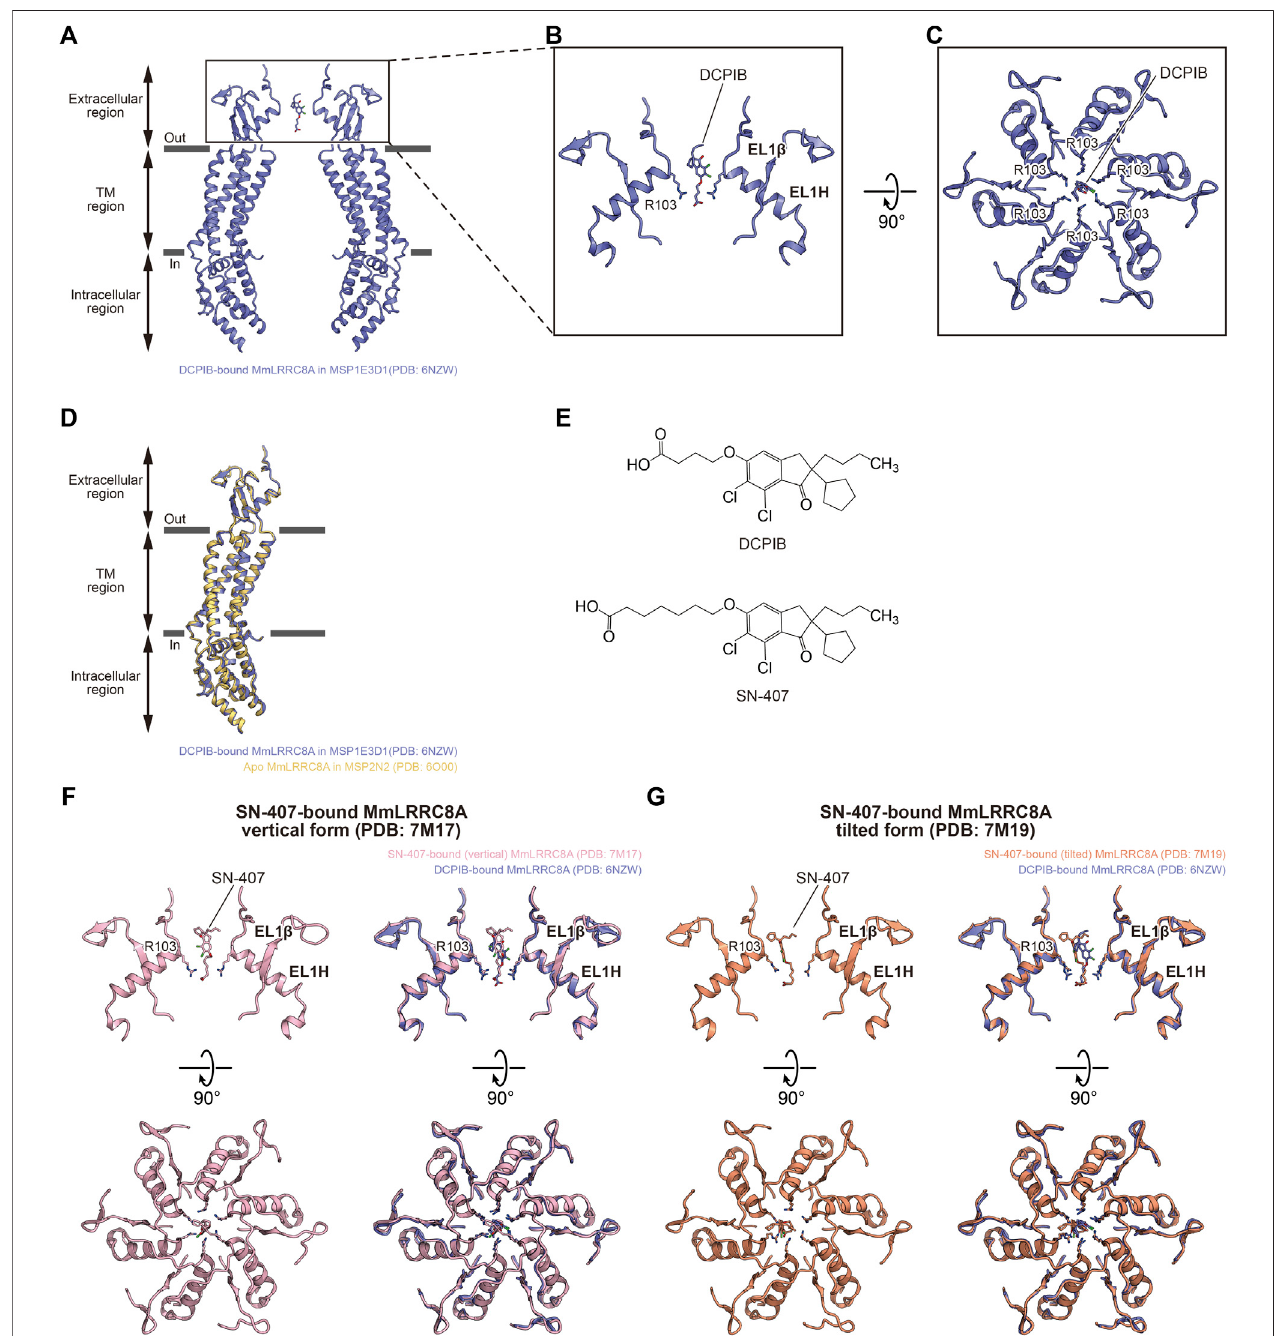
FIGURE 3 | Pore inhibition. (A – C) Overall (A) and close-up (B,C) views of the DCPIB binding site of DCPIB-bound, constricted MmLRRC8A in MSP1E3D1 nanodiscs (PDB: 6NZW) (Kern et al., 2019). The DCPIB molecule and side chains of R103 residues are depicted in stick representations. In (A,B) only two diagonal subunitsviewedparalleltothemembraneareshownforclarity.In (C) ,allsixsubunitsviewedfromtheextracellularsideareshown. (D) SuperimpositionofDCPIB-bound, constricted MmLRRC8A in MSP1E3D1 nanodiscs (PDB: 6NZW) (Kern et al., 2019) (blue) and apo MmLRRC8A in MSP2N2 nanodiscs (PDB: 6O00) (Kern et al., 2019) (orange), using the C α atoms (residues Pro15-Asn408) of the subunits. The root mean square deviation (RMSD) value is 0.50 Å for 303 C α atoms. (E) Chemical structures of DCPIB and SN-407. (F) Close-up view of the SN-407 binding site of SN-407-bound MmLRRC8A in MSP1E3D1 nanodiscs (vertical form) (PDB: 7M17) (Gunasekaretal.,2022)(left).SuperimpositionofSN-407-boundMmLRRC8AinMSP1E3D1nanodiscs(verticalform)(PDB:7M17)(Gunasekaretal.,2022)andDCPIB- bound, constricted MmLRRC8A in MSP1E3D1 nanodiscs (PDB: 6NZW) (Kern et al., 2019) (right). (G) Close-up view of the SN-407 binding site of SN-407-bound MmLRRC8AinMSP1E3D1nanodiscs(tiltedform)(PDB:7M19)(Gunasekaretal.,2022)(left).SuperimpositionofSN-407-boundMmLRRC8AinMSP1E3D1nanodiscs (tilted form) (PDB: 7M19) (Gunasekar et al., 2022) and DCPIB-bound, constricted MmLRRC8A in MSP1E3D1 nanodiscs (PDB: 6NZW) (Kern et al., 2019) (right).